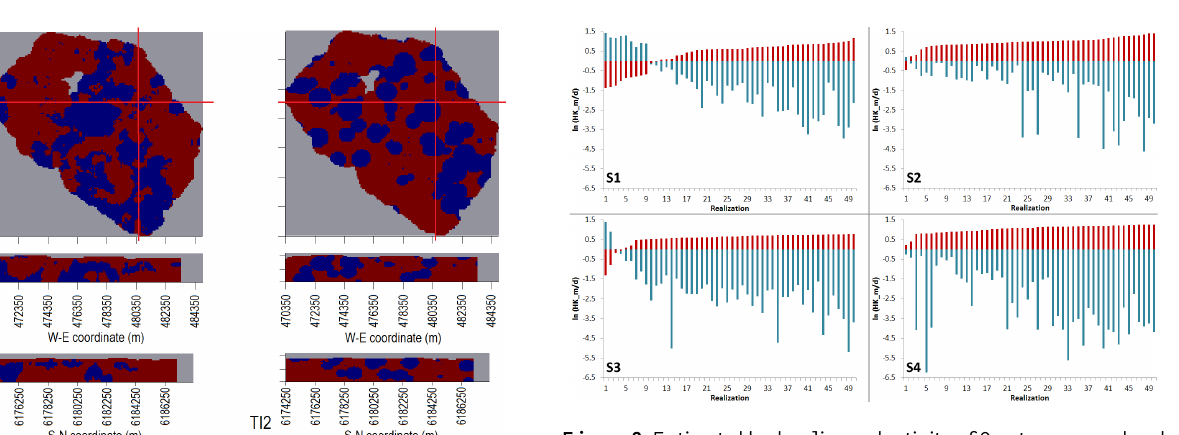
Figure 8. Estimated hydraulic conductivity of Quaternary sand and Figure 8: Estimated hydraulic conductivity of Quaternary sand and Quaternary clay using PEST. 2 Quaternary clay using PEST. The realizations are ranked according The realizations are ranked according to the hydraulic conductivity of the Quaternary sand. 3 to the hydraulic conductivity of the Quaternary